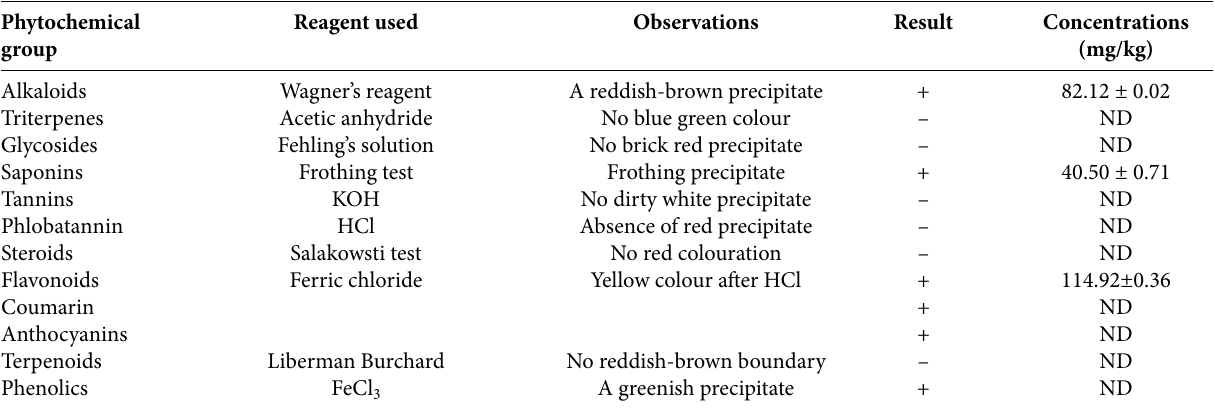
Table 1. Qualitative and quantitative phytochemical screening of E. chlorantha Phytochemical Reagent used Observations Result Concentrations group (mg/kg) Alkaloids Wagner’s reagent A reddish-brown precipitate Triterpenes Acetic anhydride